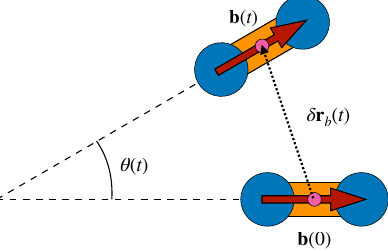
Figure 13. Schematic representation of the angle covered by a given bond in a time interval t , θ ( t ) , and δ r b ( t ) , the displacement of the bond position, i.e., the center of mass of the two monomers linked by the bond.